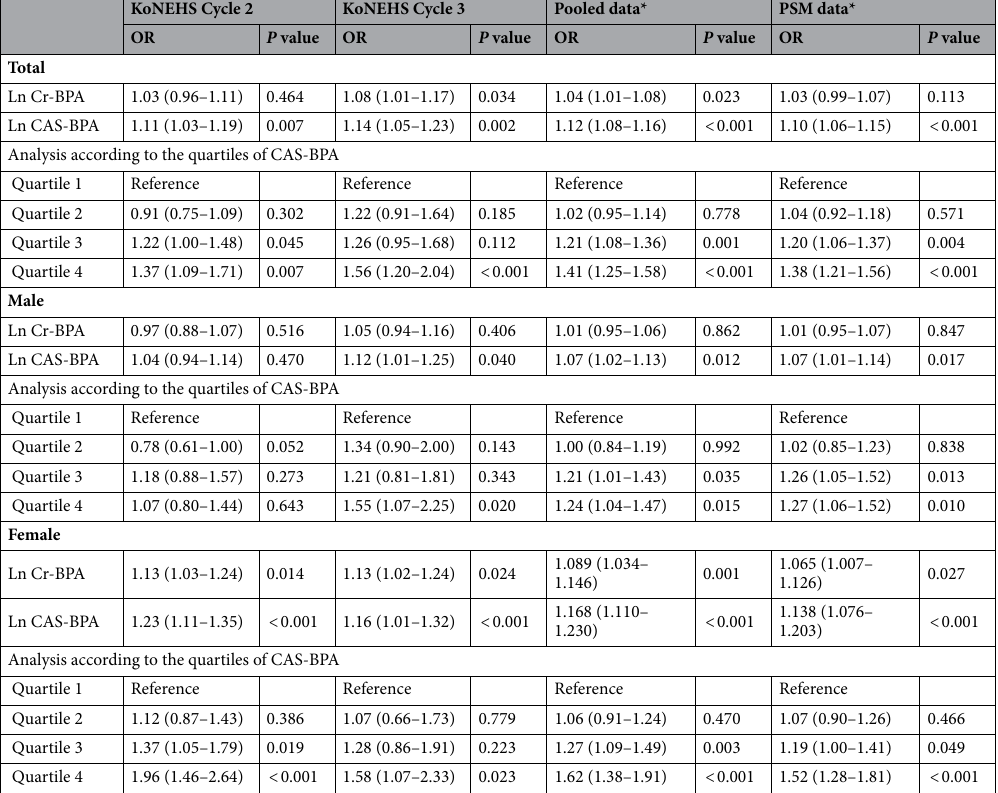
Table 4. Adjusted odds ratios (95% confidence intervals) for obesity according to urinary bisphenol A. Adjusted for age, sex, household income, smoking, alcohol consumption, and physical activity. PSM,